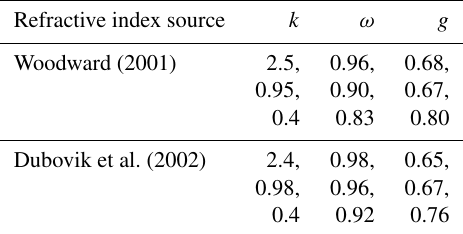
Table A3. Dust optical properties for the ECRAD band 400–700nm computed using different refractive indices (mass extinction coeffi- cient k , in square metres per gram, single scattering albedo ω and asymmetry parameter g ). Data are for each of the three size bins of the CAMS aerosol model (bin limits in terms of particle radius: 0.03, 0.55, 0.9 and